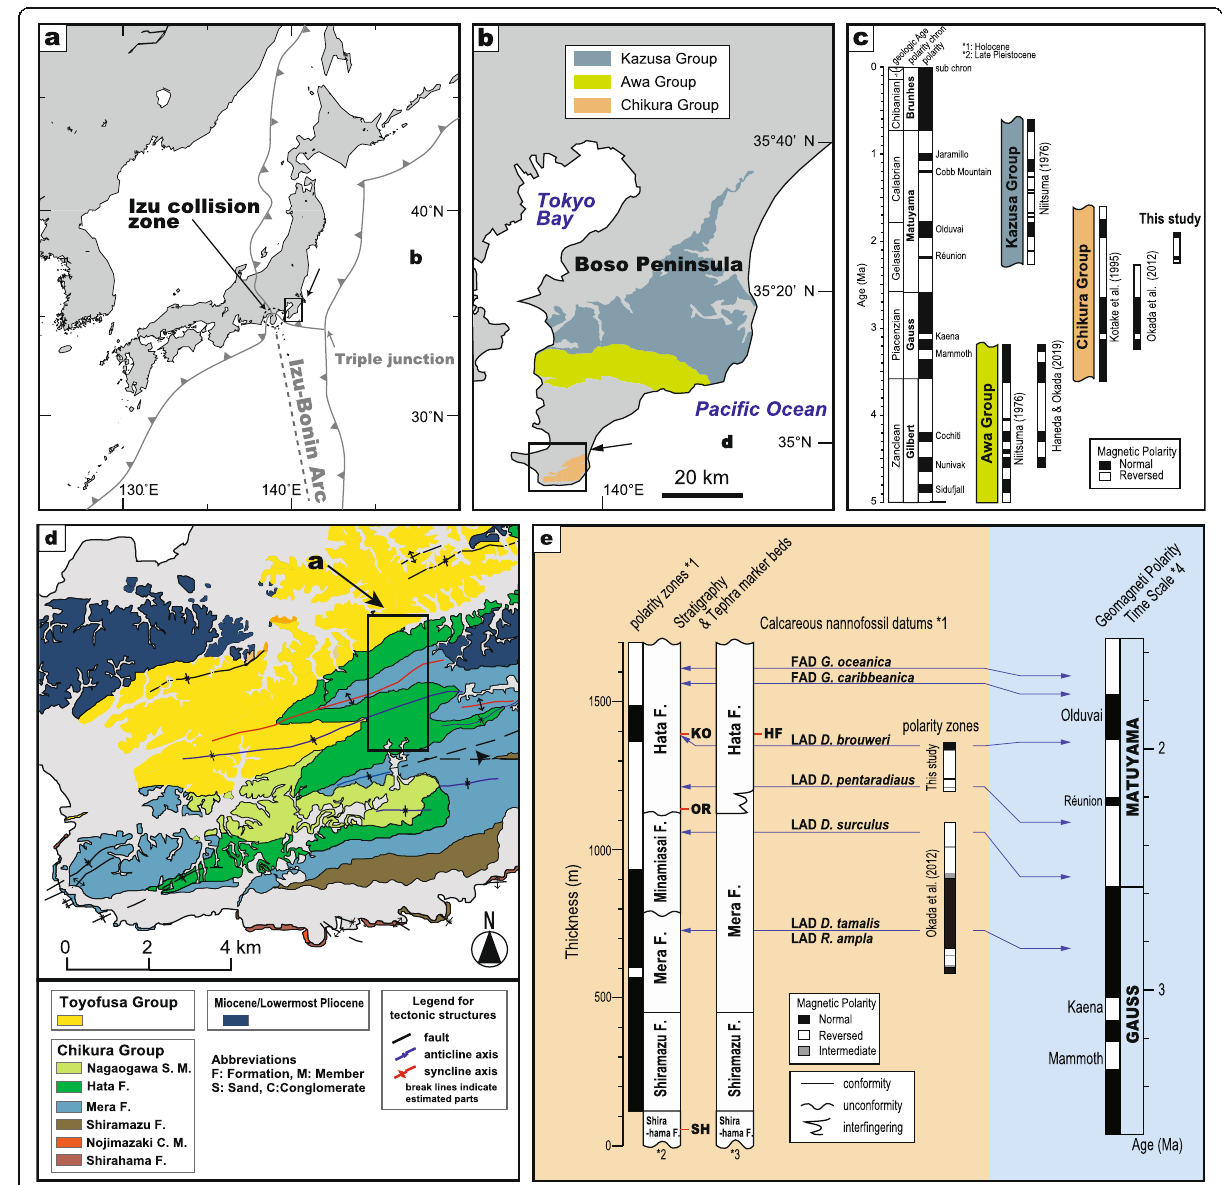
Fig. 1 Location map of this study sites. a Location of the Japanese archipelago. The tectonic setting is drawn after Tatsumi et al. (2016). b Distribution of the Awa Group, the Chikura Group, and the Kazusa Group, which are Miocene-Pleistocene marine successions on the Boso Peninsula based on Mitsunashi and Suda (1980), Unozawa et al. (1983), and Kawakami and Shishikura (2006). c Chronological positions for the last 5 Ma of the Awa Group, the Chikura, and the Kazusa Group associated with the magnetostratigraphy. d Geologic map of the southernmost part of the Boso Peninsula, modified from Kawakami and Shishikura (2006). e Stratigraphic correlation of the Chikura Group associated with the magnetostratigraphy and the calcareous nannofossil datums. *1 Kotake et al. (1995), *2 Kotake (1988), *3 Kawakami and Shishikura (2006), *4 Ogg